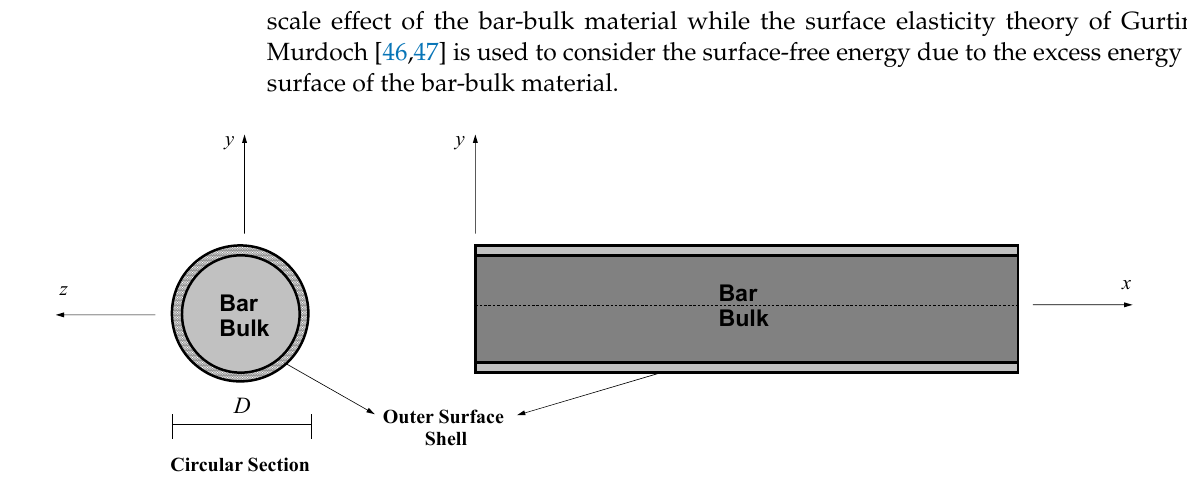
Figure 1. Nanobar section with a warping surface layer.